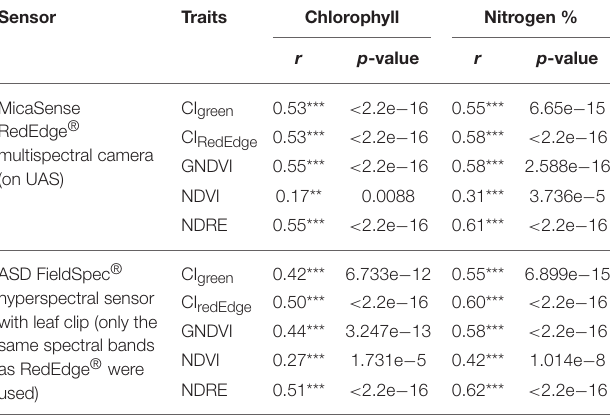
TABLE 6 | Student’s t -test results showing significant differences of remotely sensed VIs between low (192 plots) and high (192 plots) nitrogen treatments. VI t p -value CI Green